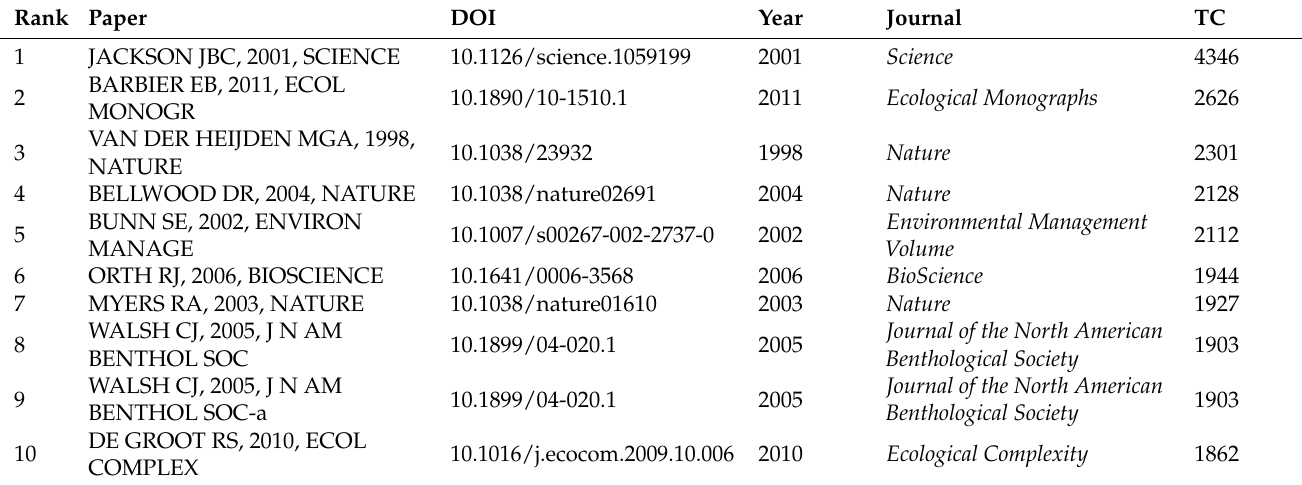
Table 1. Top 10 most cited publications in the field of ecological restoration from 1990 to 2022.